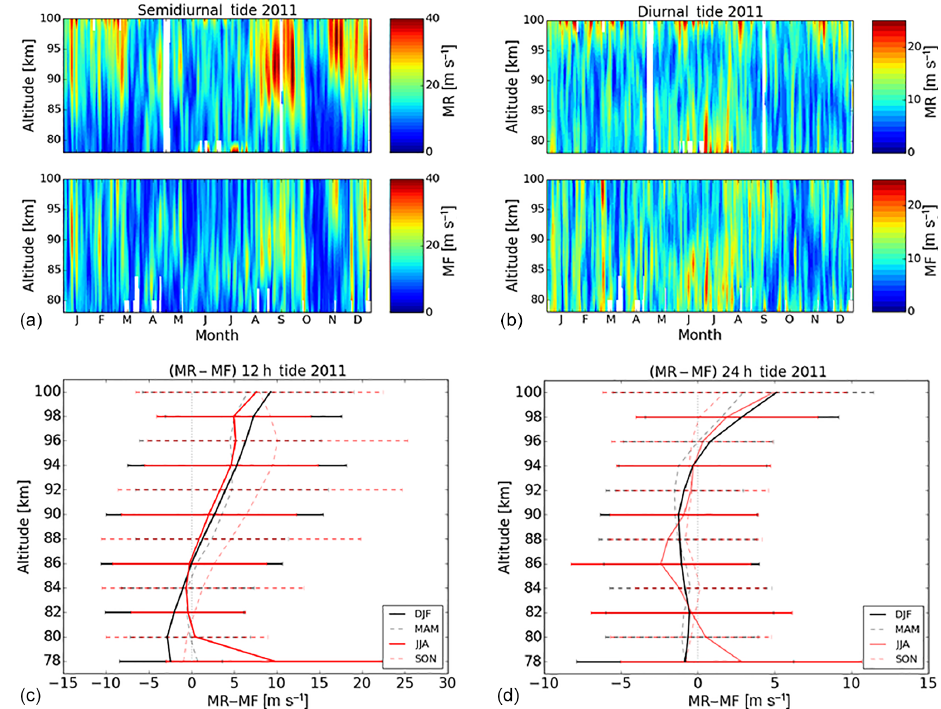
Figure 5. Semidiurnal (a) and diurnal tides (b) in 2011 for both systems. The white areas are missing values bases on outliers or due to maintenance. (c, d) Calculated difference for SDT and DT between MR and MF for the seasons DJF (solid black), MAM (dashed black), JJA (solid red), and SON (dashed red) for the year 2011. The error bars correspond to the seasonal variability.